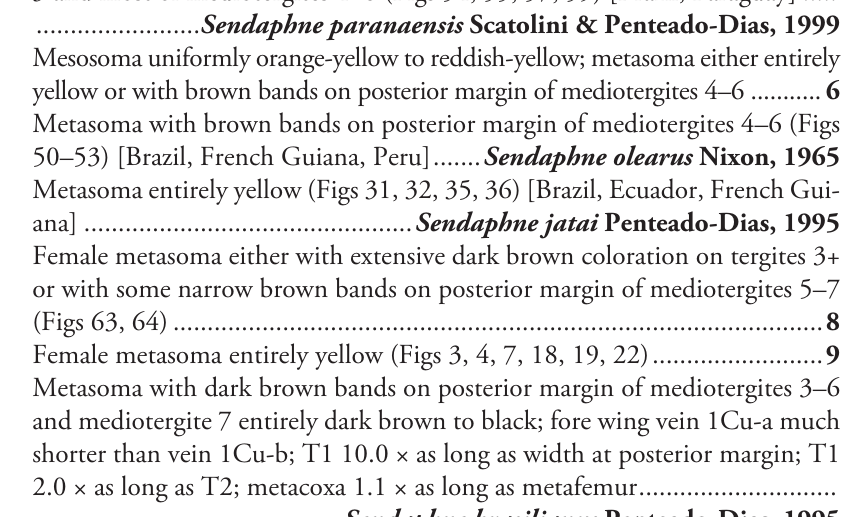
Tegula, metacoxa and mediotergites 1–2 yellow to reddish-yellow (Figs 23–28, 37–40, 42–44); body less slender, metasoma shorter than combined length of head and mesosoma (Figs 23, 37) [Ecuador, Mexico] .................. 3 3(2) Mediotergite 1 length 6.0 × its width at posterior margin, mediotergite 2 length 1.5 × its width at posterior margin (Figs 24, 25, 28); first discal cell 2.0 × as wide as high (Fig. 24) [Ecuador] ...................................................... – Mediotergite 1 length 4.0 × its width at posterior margin, mediotergite 2 length 1.0 × its width at posterior margin (Figs 39, 42, 44); first discal cell 1.3 × as wide as high (Fig. 39) [Mexico] ....................................................... 4(1) – 5(4) Mesosoma with dark brown areas on anteromesoscutum and mesopleuron (Figs 54, 56, 58); dark brown coloration on posterior margin of mediotergite 3 and most of mediotergites 4–6 (Figs 54, 55, 57, 59) [Brazil, Paraguay] ..... – Mesosoma uniformly orange-yellow to reddish-yellow; metasoma either entirely yellow or with brown bands on posterior margin of mediotergites 4–6 ........... 6 6(5) Metasoma with brown bands on posterior margin of mediotergites 4–6 (Figs 50–53) [Brazil, French Guiana, Peru] ....... Sendaphne olearus Nixon, 1965 – Metasoma entirely yellow (Figs 31, 32, 35, 36) [Brazil, Ecuador, French Gui- 7(4) Female metasoma either with extensive dark brown coloration on tergites 3+ or with some narrow brown bands on posterior margin of mediotergites 5–7 (Figs 63, 64) ............................................................................................... 8 – Female metasoma entirely yellow (Figs 3, 4, 7, 18, 19, 22) ......................... 9 8(7) Metasoma with dark brown bands on posterior margin of mediotergites 3–6 and mediotergite 7 entirely dark brown to black; fore wing vein 1Cu-a much shorter than vein 1Cu-b; T1 10.0 × as long as width at posterior margin; T1 2.0 × as long as T2; metacoxa 1.1 × as long as metafemur ............................. – Metasoma with some narrow brown bands on posterior margin of medi- otergites 5–7 (Figs 63, 64); fore wing veins 1Cu-a and 1Cu-b subequal; T1 6.0 × as long as width at posterior margin; T1 1.4 × as long as T2; metacoxa 0.9–1.0 × as long as metafemur .................................................................... 9(7) Fore wing r and 2RS not clearly distinct from each other (Fig. 3); medioter- gite 2 length 1.0 × its width at posterior margin (Figs 3, 4, 7); face centrally orange (Fig. 2); ovipositor 1.8–1.9 × as long as metatibia [Ecuador] ............. – Fore wing with veins r and 2RS clearly distinct from each other, and meeting at a sharp angle (not clearly visible in Fig. 17); mediotergite 2 length